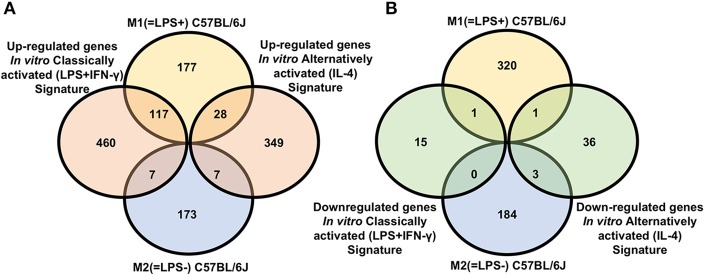
Signature comparison for C57BL/6 macrophages. (A) Venn diagram showing overlap between genes whose expression was positively [M1(=LPS+)C57BL/6J] or negatively [M2(=LPS–)C57BL/6J] correlated with IL12/arginase ratio in vivo with genes upregulated in vitro classically activated (LPS+IFN-γ) macrophages (left) or in vitro alternatively activated (IL-4) (right) macrophages vs. unstimulated. (B) Venn diagram showing overlap between genes whose expression was positively [M1(=LPS+)C57BL/6J] or negatively [M2(=LPS–)C57BL/6J] correlated with IL12/arginase in vivo with genes downregulated in vitro classically activated (LPS+IFN-γ) macrophages (left) or in vitro alternatively activated (IL-4) (right) macrophages vs. unstimulated.